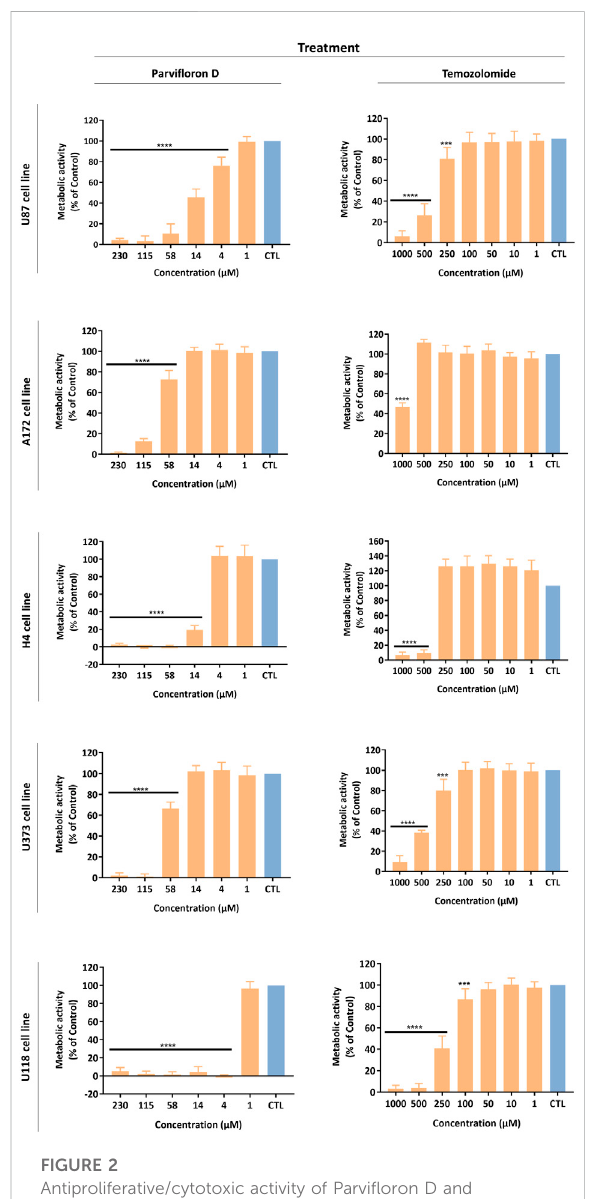
FIGURE 2 Antiproliferative/cytotoxic activity of Parvi fl oron D and temozolomide against U87, A172, H4, U373, and U118 cell lines. Cells were treated either with Parvi fl oron D or with temozolomide for 48 h and subsequently Alamar blue assay was performed. Cell viability was expressed as percentage of control (CTL) (untreated cells). Asterisks (**** p < 0.0001) represent the values that signi fi cantly differ from the control. Data were presented as mean ± SD and are representative from at least three independent